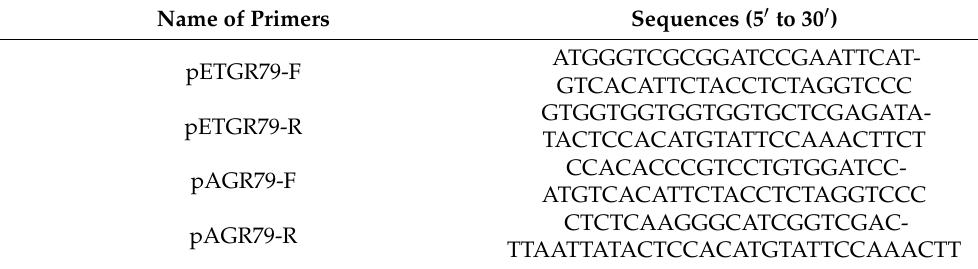
Table 1. Primers used in this